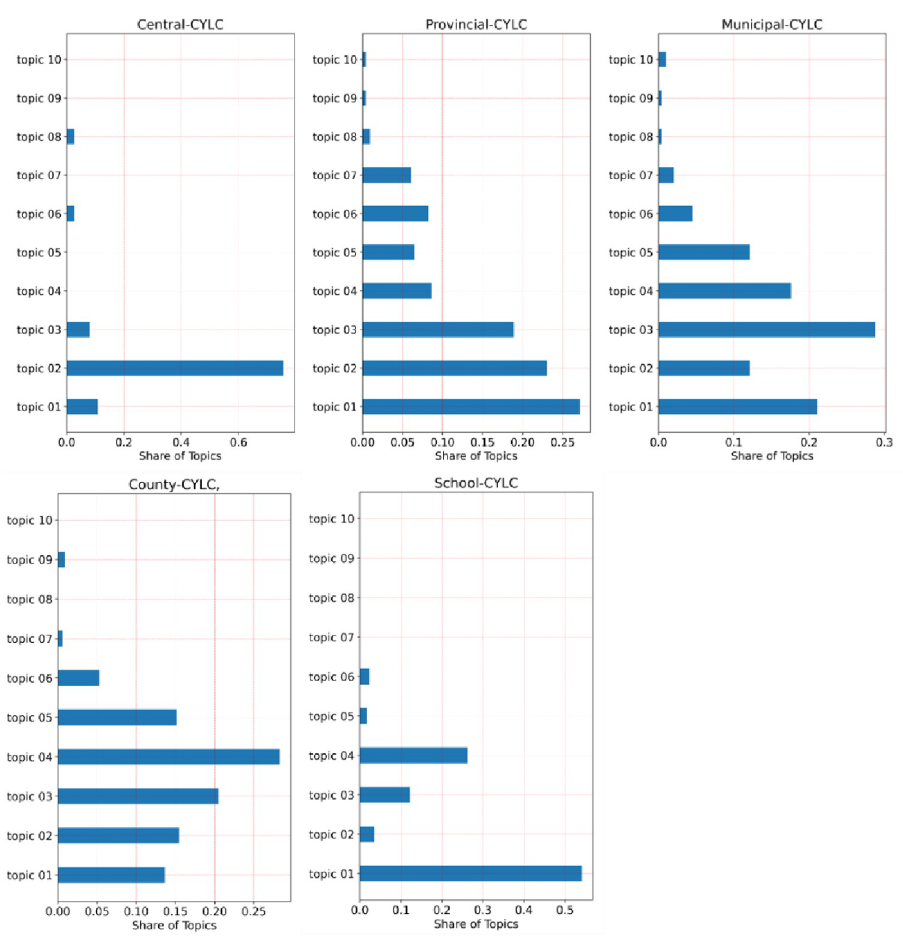
Fig 7. Distribution of news topics of league organizations at all levels.